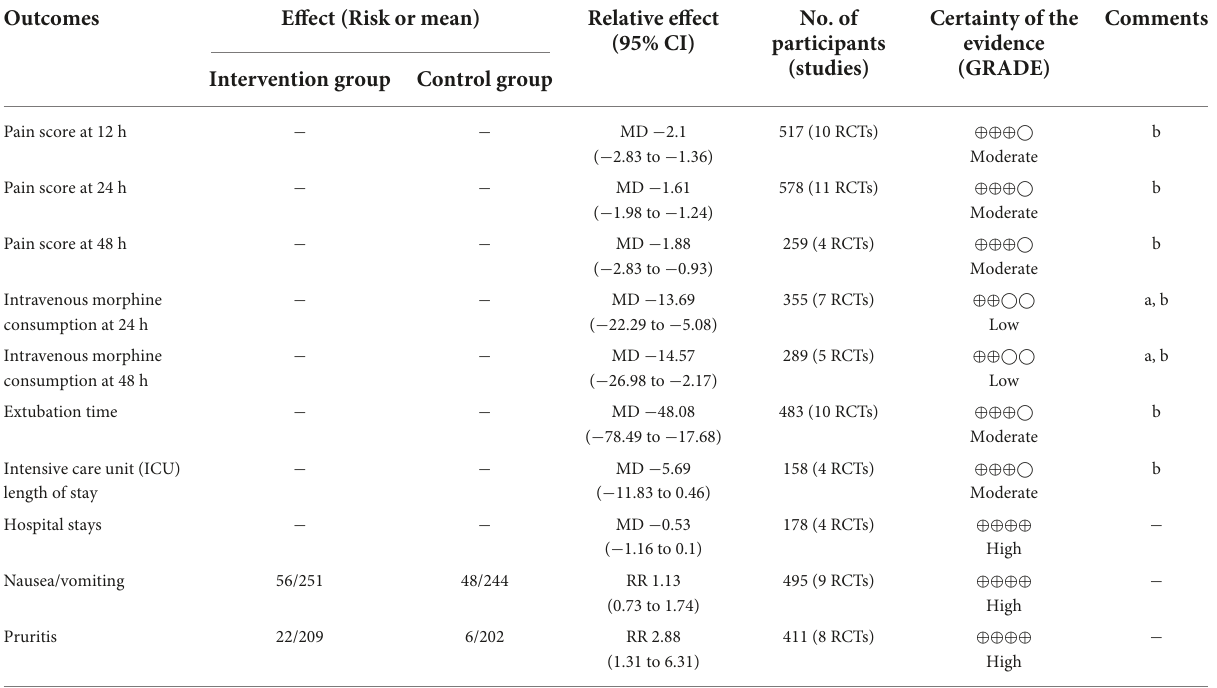
TABLE 2 Summary of findings for the main